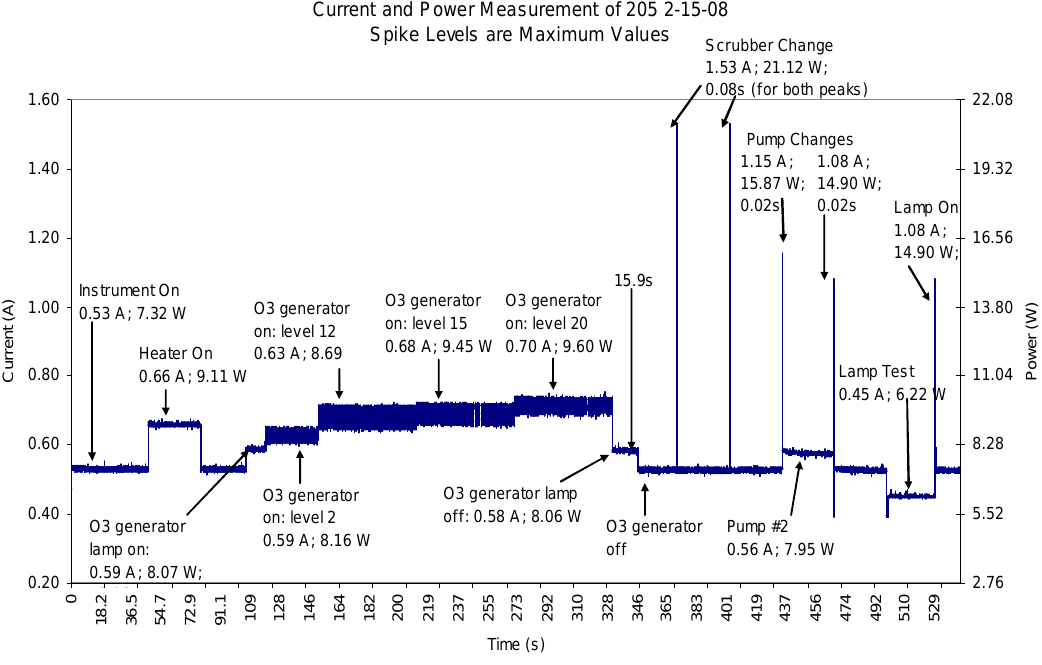
Fig. 3. Power plot of the ozone instrument in its various states of operation. In its baseline operation state the instrument draws approximately 7.3W. Such a power measurement was done for all instruments on the